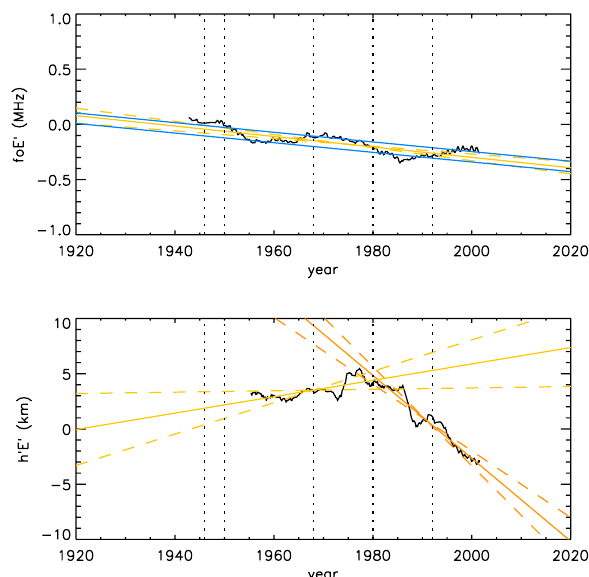
Fig. 5. Trends in f oE 0 (upper panel) and h 0 E 0 (lower panel) us- ing the minimum chi-squared method and dividing the h 0 E 0 time series into pre and post 1980 parts. Black lines: smoothed time series; solid lines show the linear fits, dashed lines the uncertain- ties; vertical dotted lines indicate dates when system changes were made. For fits to h 0 E 0 , light orange is used for the pre-1980 subset and dark orange for the post-1980 subset. The trends are as fol- lows: f oE 0 , − 0.05MHz decade − 1 ± 25%; h 0 E pre-1980, +0.7km